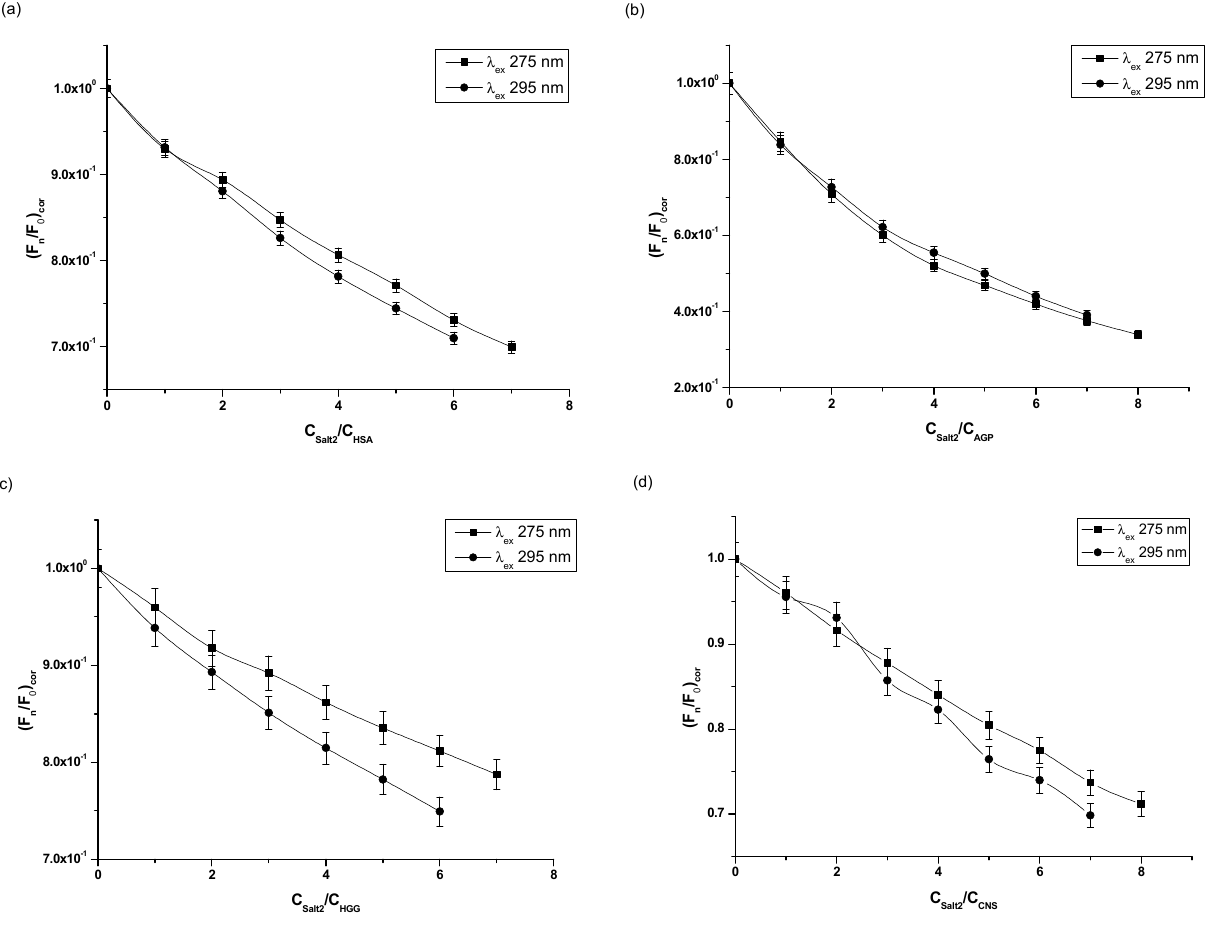
Figure 2. Fluorescence quenching curves of ( a ) HSA, ( b ) AGP, ( c ) HGG, ( d ) CNS at molar concen- tration 3 × 10 − 6 mol · L − 1 in the presence of Salt2 at increasing concentration ( λ ex 275 nm and λ ex 295 nm).